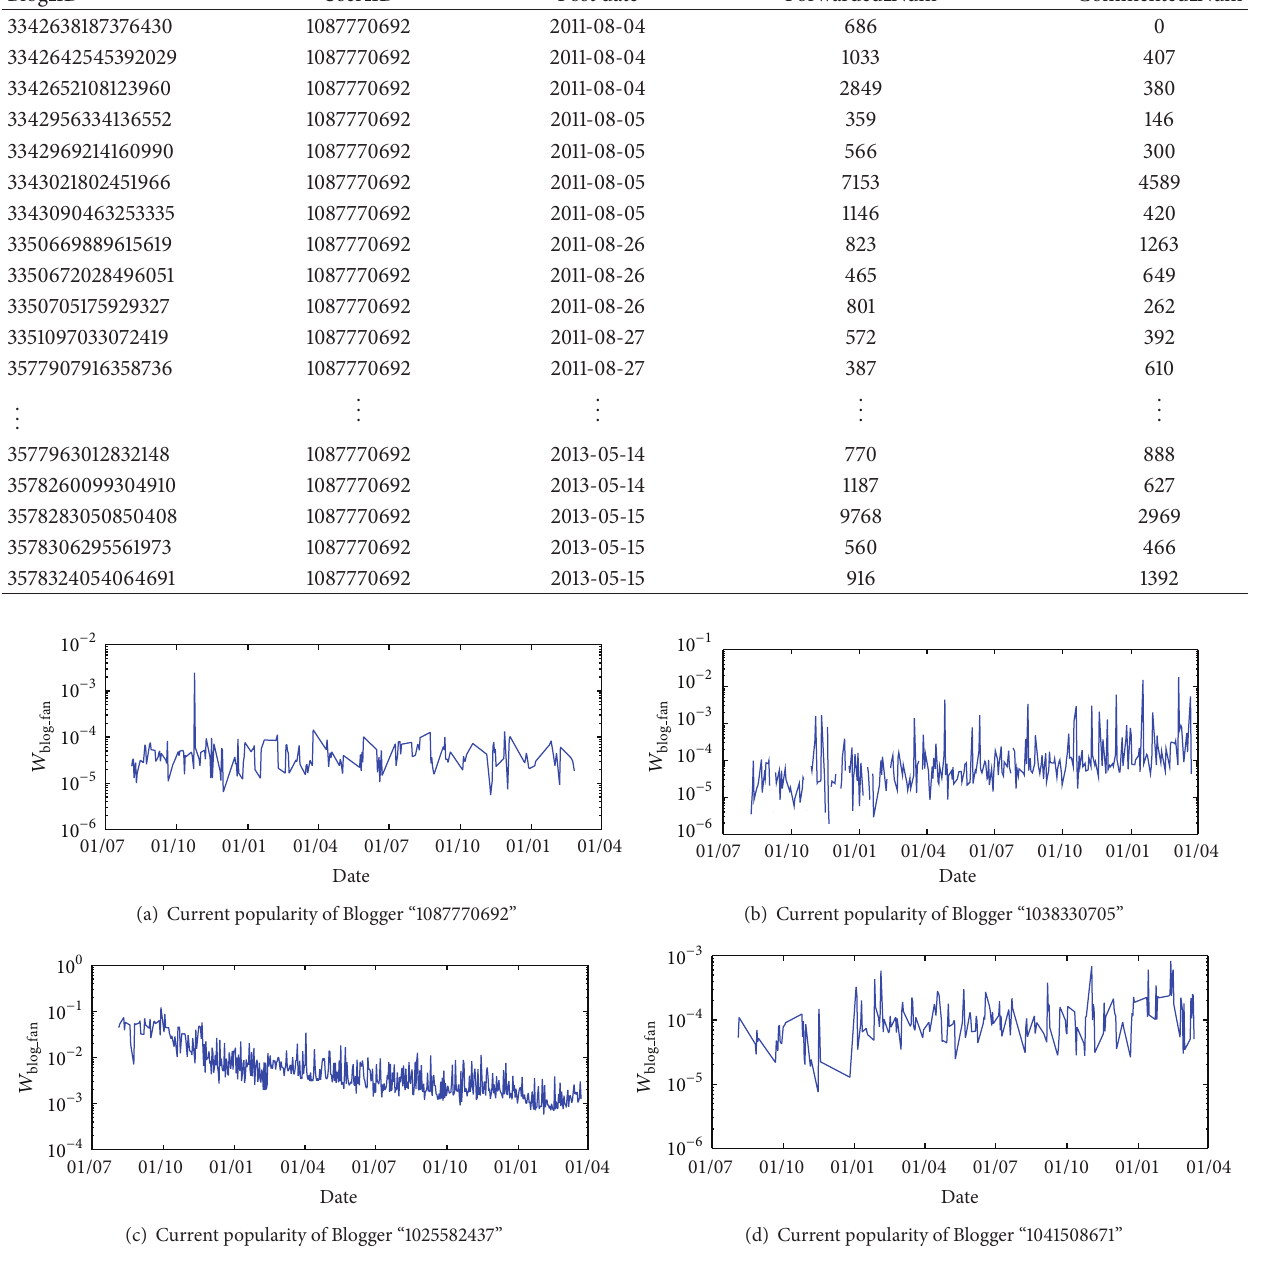
Figure 13: Current popularities of microbloggers from 2011 to